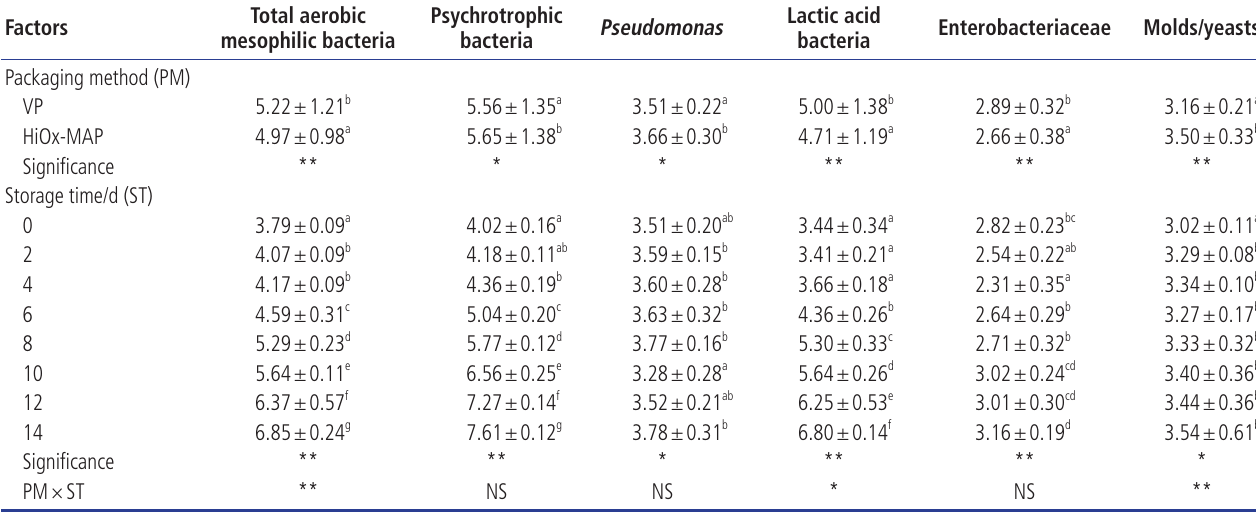
Table 3. Effects of vacuum packaging (VP) and high-oxygen modified atmosphere packaging (HiOx-MAP, 80% O minced water buffalo meat at 2°C±0.5°C for 14 days (mean±standard deviation)